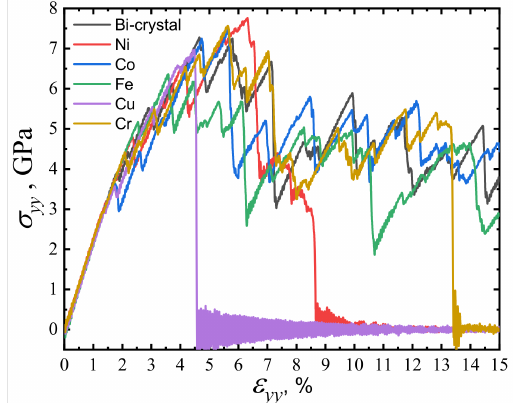
Figure 4. The tensile stress–strain curves for the considered bicrystals. The corresponding type of segregated element is indicated in the legend for each bicrystal, while the case without GB segregation is labeled as Bicrystal. The stress drop to zero corresponds to a break in the bicrystal. The considered temperature is 300